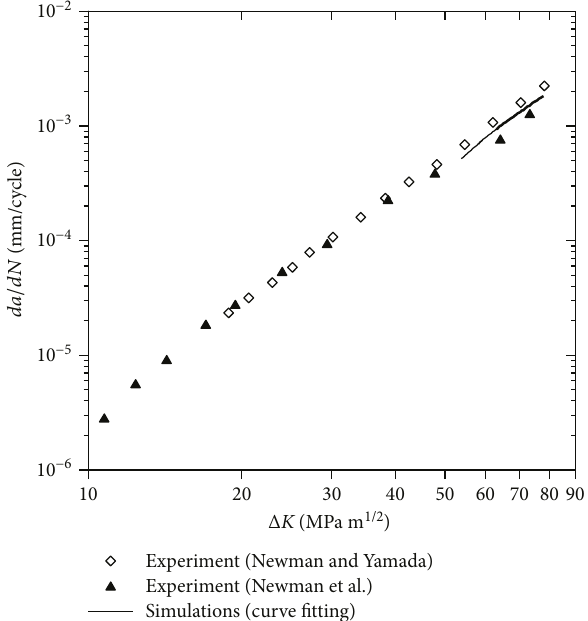
Figure 7: Plot of the experimental results and the corresponding fi tting curves of the CCZM in the Paris ’ region.